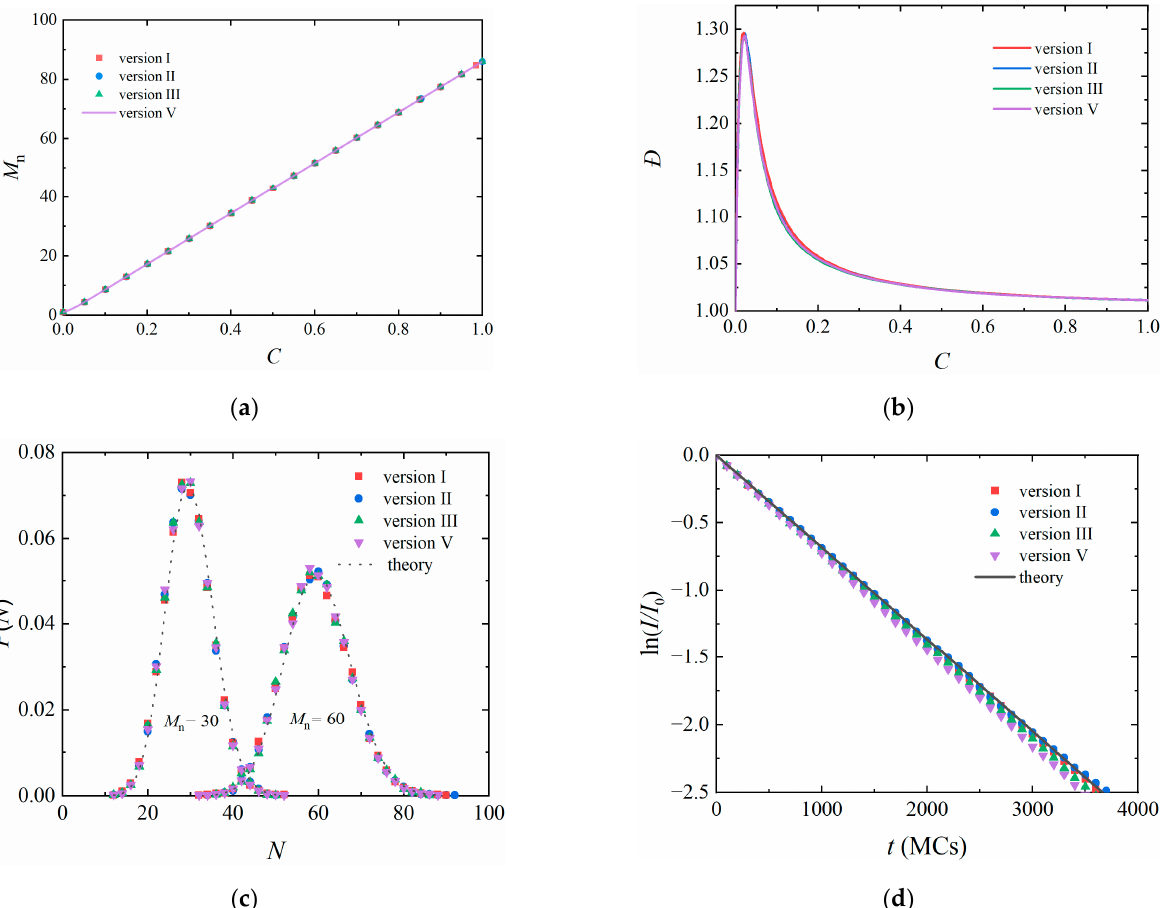
Figure 2. A living polymerization with randomly dispersed free monomers and initiators studied by different versions of stochastic reaction model. ( a ) Number ‐ average molecular weight M n and ( b ) dispersity ( Ð ) as a function of the monomer conversion C . ( c ) Molecular weight distribution with M n = 30 and 60 respectively. The dotted lines are drawn according to a Poisson distribution. ( d ) The ratio of unreacted initiators during polymerization. The reaction interval time τ = 10 MCs, and the reaction probability between one active center and one monomer P 0 = 0.001.